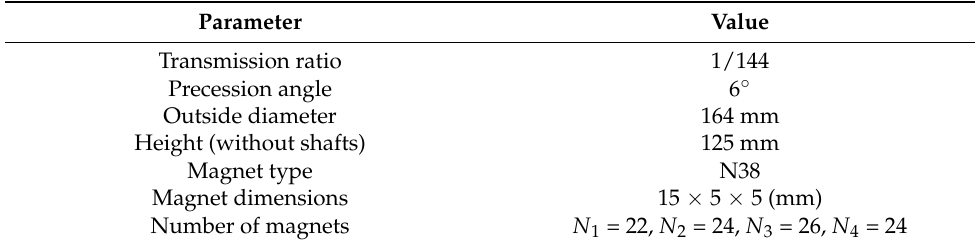
Figure 8. MPG prototype: ( a ) construction and ( b ) picture. Table 1. Prototype